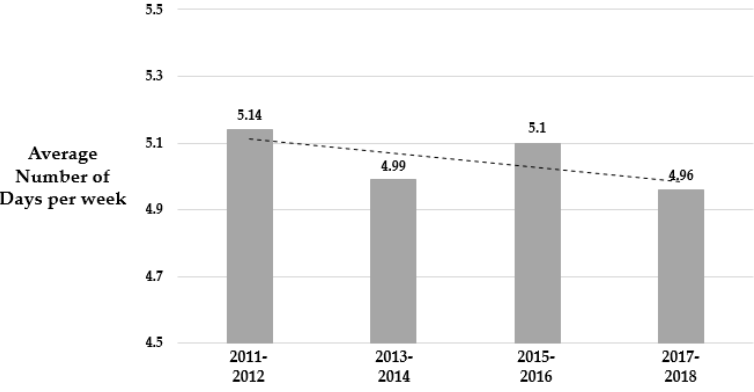
Figure 2. Weighted mean number of days physically active days for the overall sample from 2011 to 2017 ( N = 51,616).